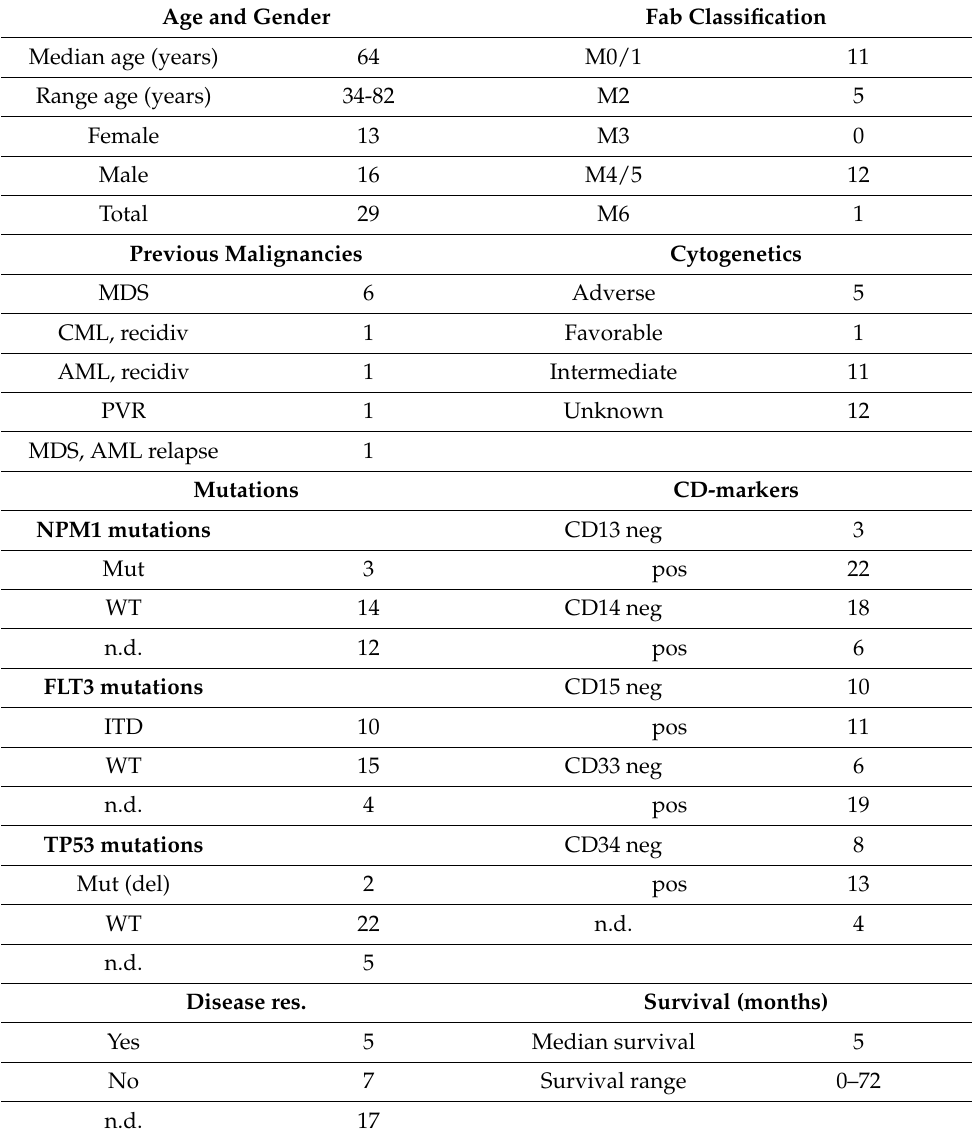
Table 2. AML patient characteristics (French–American–British (FAB)